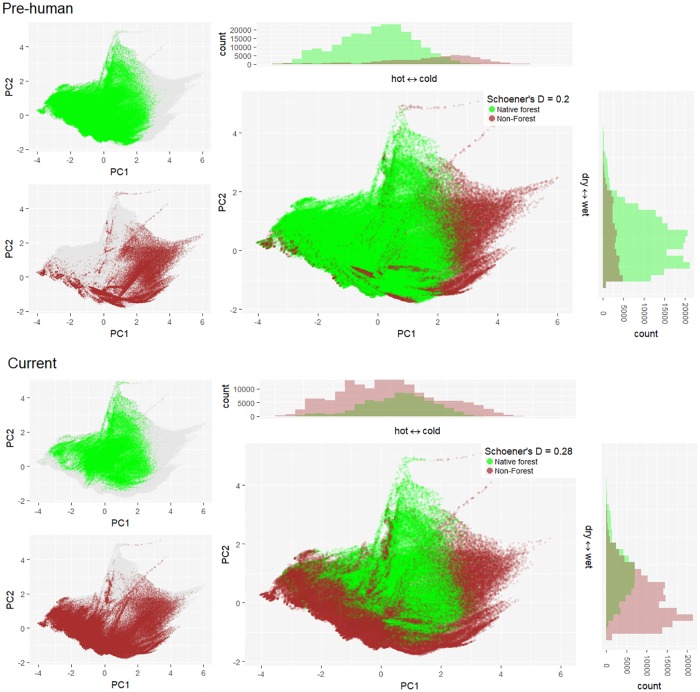
Climate conditions of forest and non-forest areas in New Zealand before and after human settlement.Climate conditions of forest (green dots) and non-forest, i.e., open habitat (brown dots) are shown on the first two axes of a Principal Component Analysis of four climate variables (see Methods) at 1 km grid resolution. The total climate space of New Zealand is shown in dark grey. Schoener’s D values indicate the overlap in climate conditions between forest and non-forest areas (0 = no overlap; 1 = full overlap).